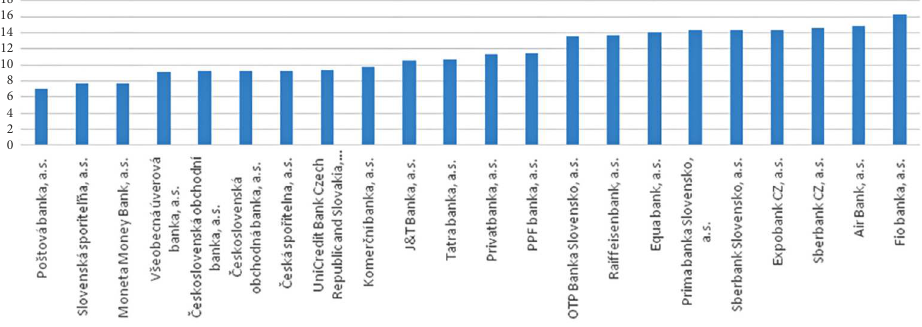
Fig. 1. Overall ranking of analyzed the Czech and Slovak banks Source : prepared by